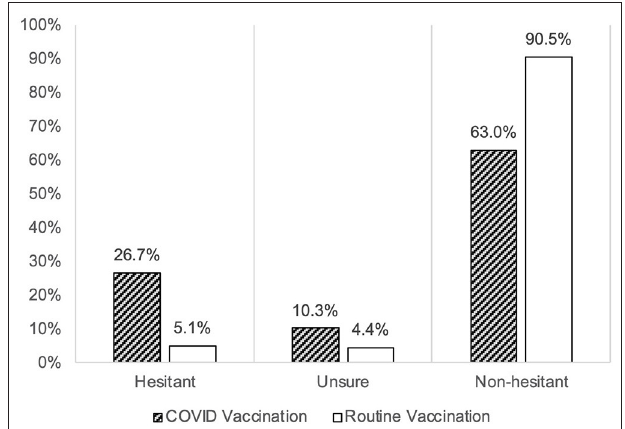
FIGURE 1 | The parental hesitancy toward childhood COVID-19 vaccination (Oxford COVID-19 Vaccine Scale) as compared to the hesitancy toward routine childhood vaccination (VHS scale), among 1,052 parents in Saudi Arabia between June 18 to June 30,